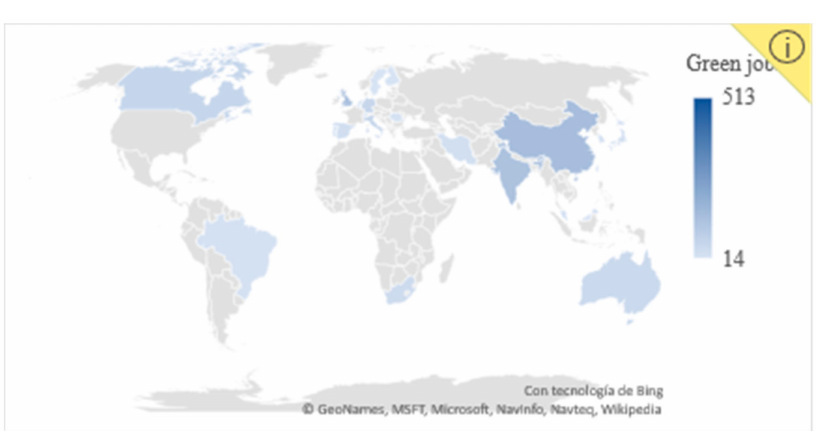
Figure 5. Countries with the biggest volume of research in green building.